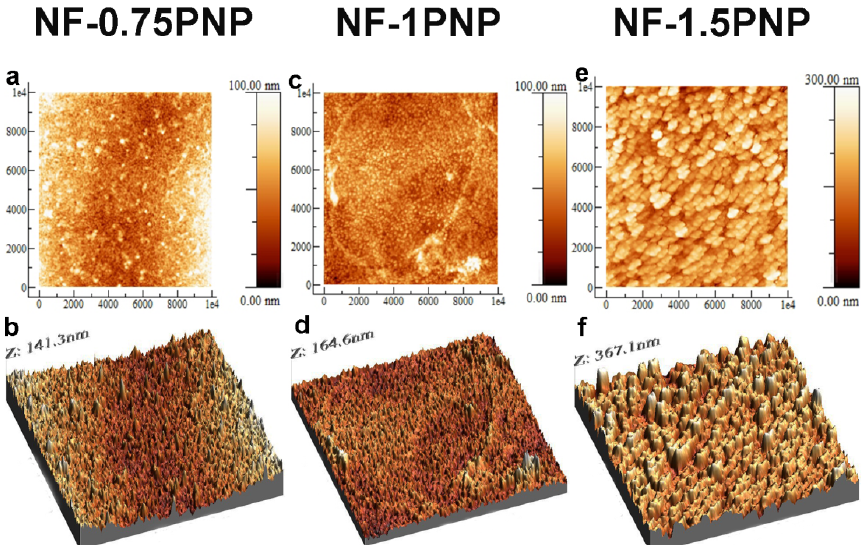
Figure 2. Three-dimensional AFM images of NF-0.75PNP (a-b), NF-1PNP (c-d), and NF- 1.5PNP